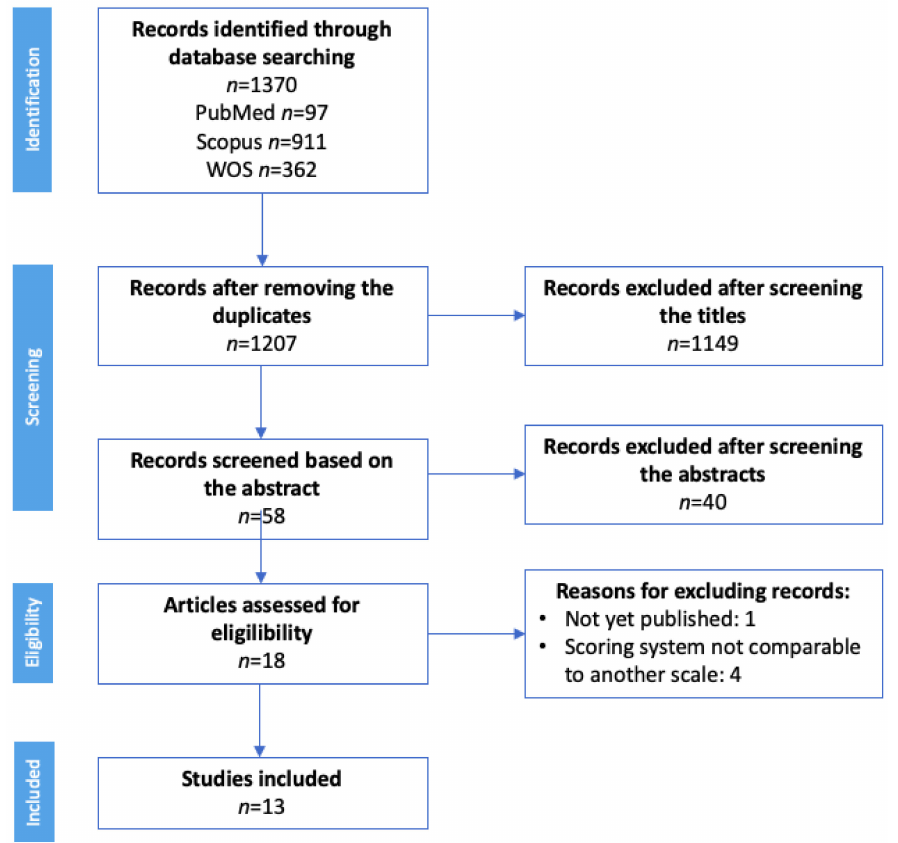
Figure 1. PRISMA flow diagram to describe the selection of previous studies for inclusion in this review. Abbreviations: WOS = Web of